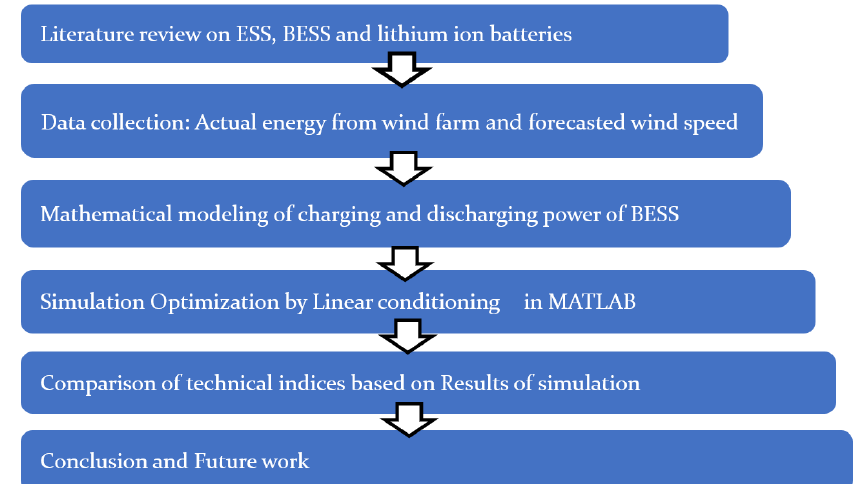
Figure 1. Flow chart of the methodology.